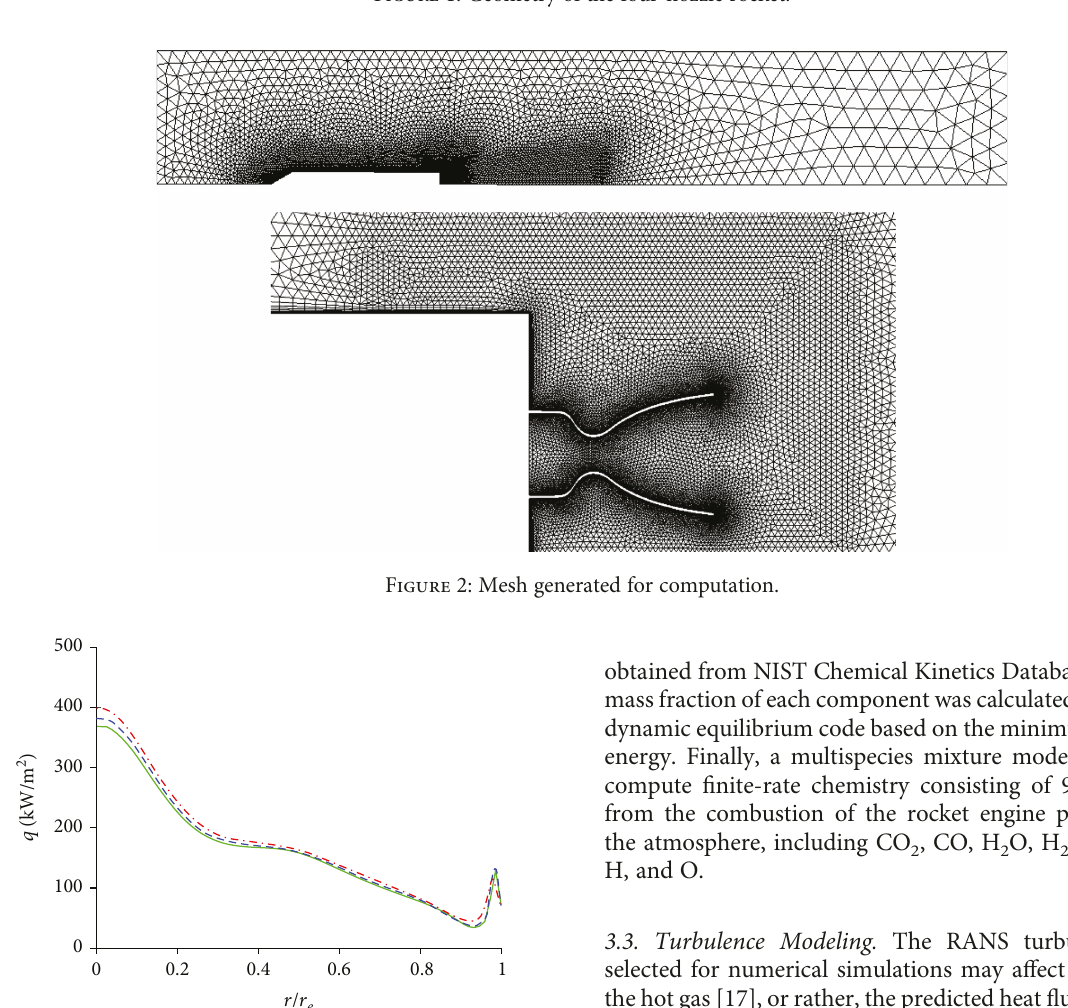
Figure 1: Geometry of the four-nozzle rocket.